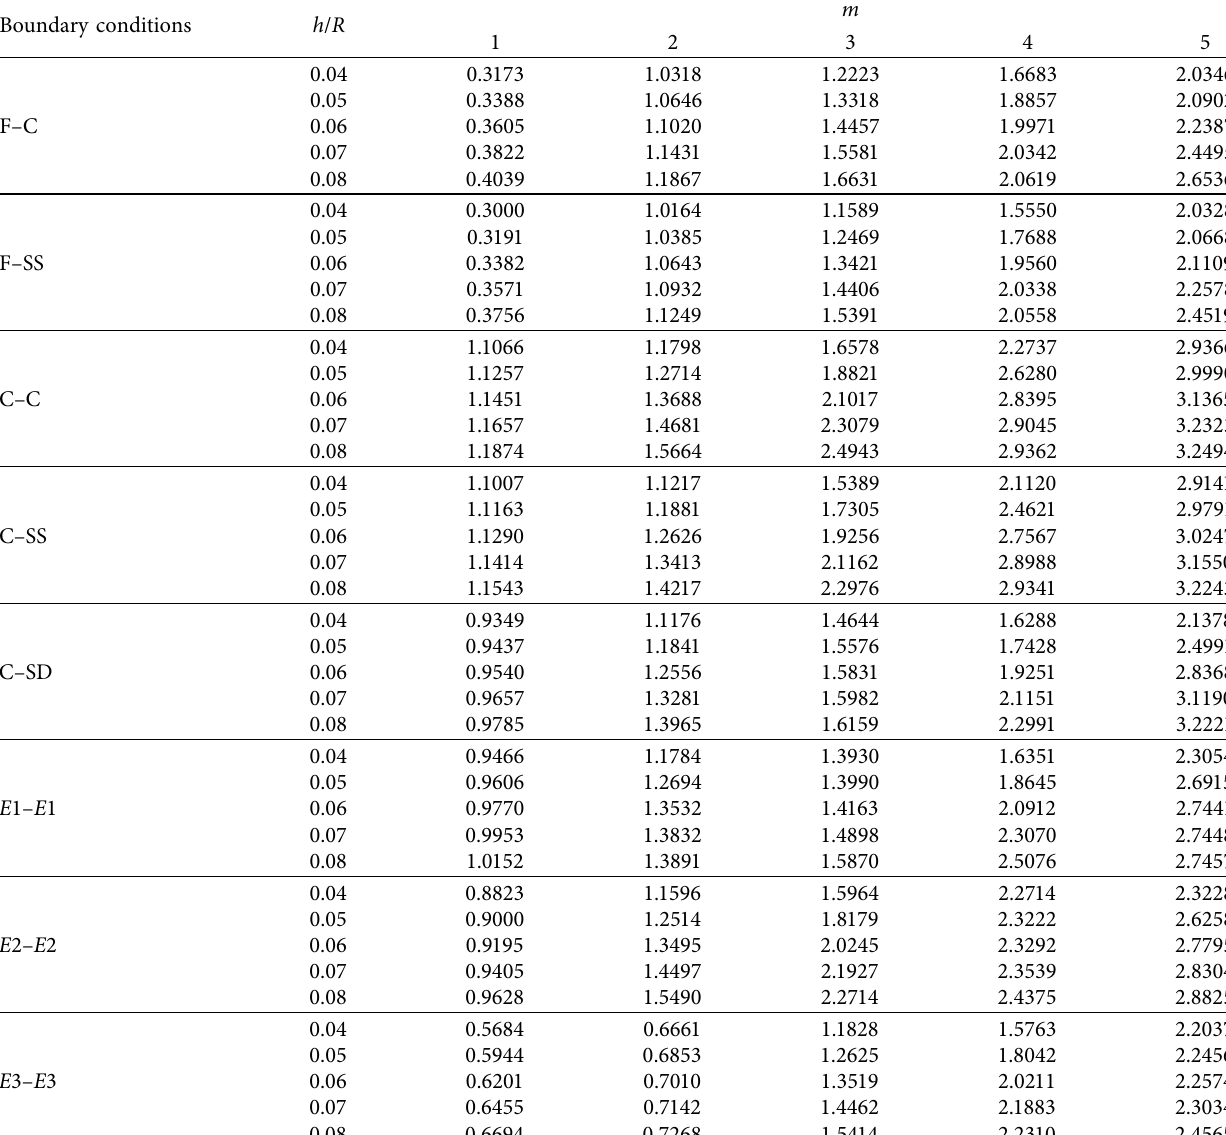
� π /6, φ � π /2, R � 1m, and n � 2). 0 1